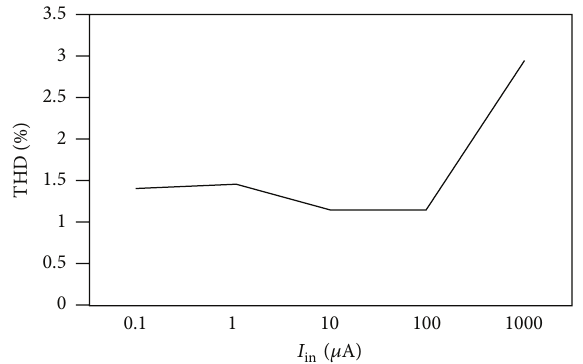
Figure 7: THD variation at output ( 𝐼 amplitude at